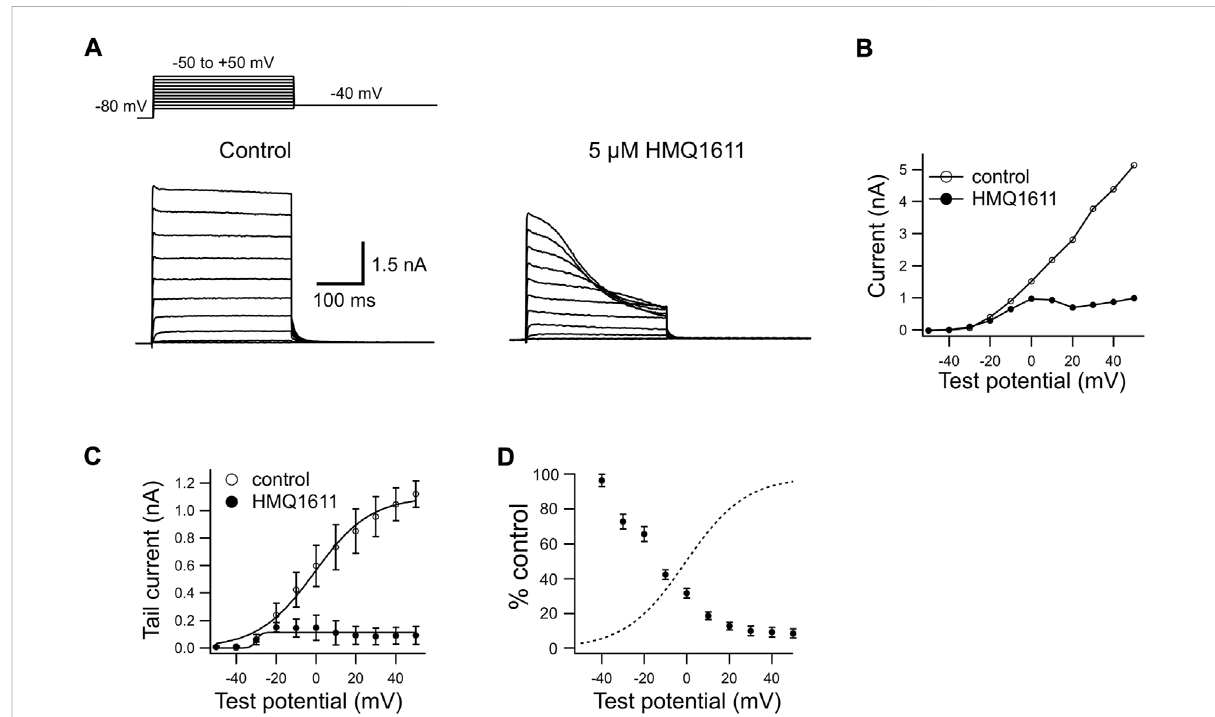
FIGURE 1 BlockingpropertiesofHMQ1611onhumanKv1.5(hKv1.5)channelsheterologouslyexpressedinChinesehamsterovarycells. (A) Superimposed hKv1.5 channel currents elicited during 300 ms depolarizing steps given from a holding potential of -80 mV to potentials between -50 and +50 mV in10 mVincrements,followedbya300 msrepolarizationstepto-40 mVbefore(Control)andafterexposureto5 μ MHMQ1611. (B) Current-voltage ( I – V ) relations of hKv1.5 currents measured at the end of 300 ms depolarization under control conditions and during exposure to 5 μ M HMQ1611. (C) I – V relations for tail currents in control and during exposure to 5 μ M HMQ1611. The smooth curves through the data points represent theleast-squares fi ttoaBoltzmannequation. (D) LatecurrentamplitudeinthepresenceofHMQ1611isplottedasapercentageofcontrolamplitude in the absence of the compound (% Control, fi lled circles). The dashed curve represents the activation curve obtained in control conditions (see Figure